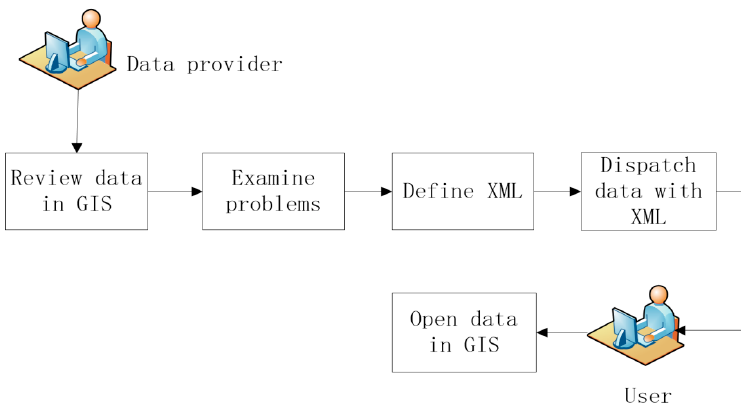
Figure 7. Workflow of defining and using XML plugin.